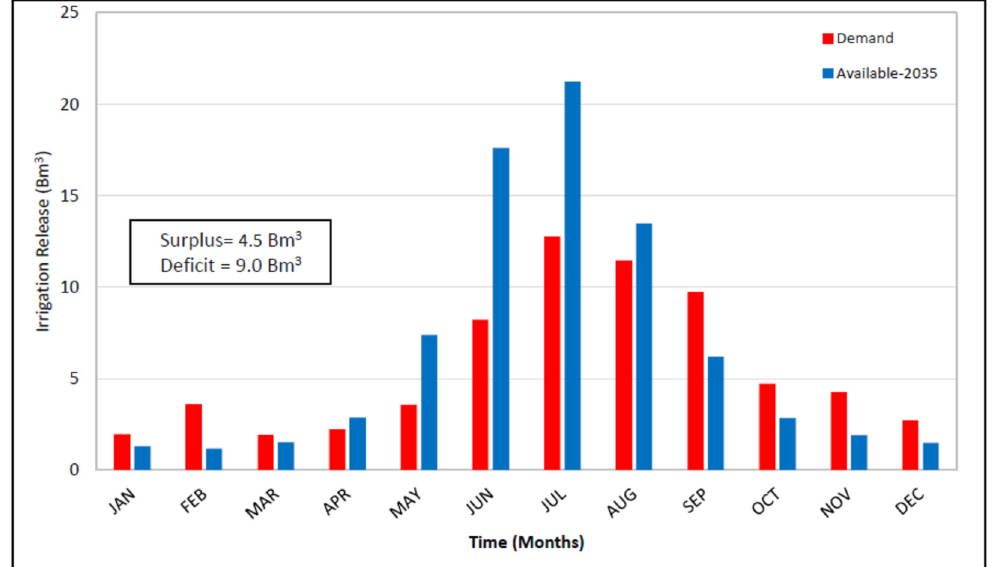
Figure 42. Comparison of Gross Storage of Tarbela Reservoir for future years [47].